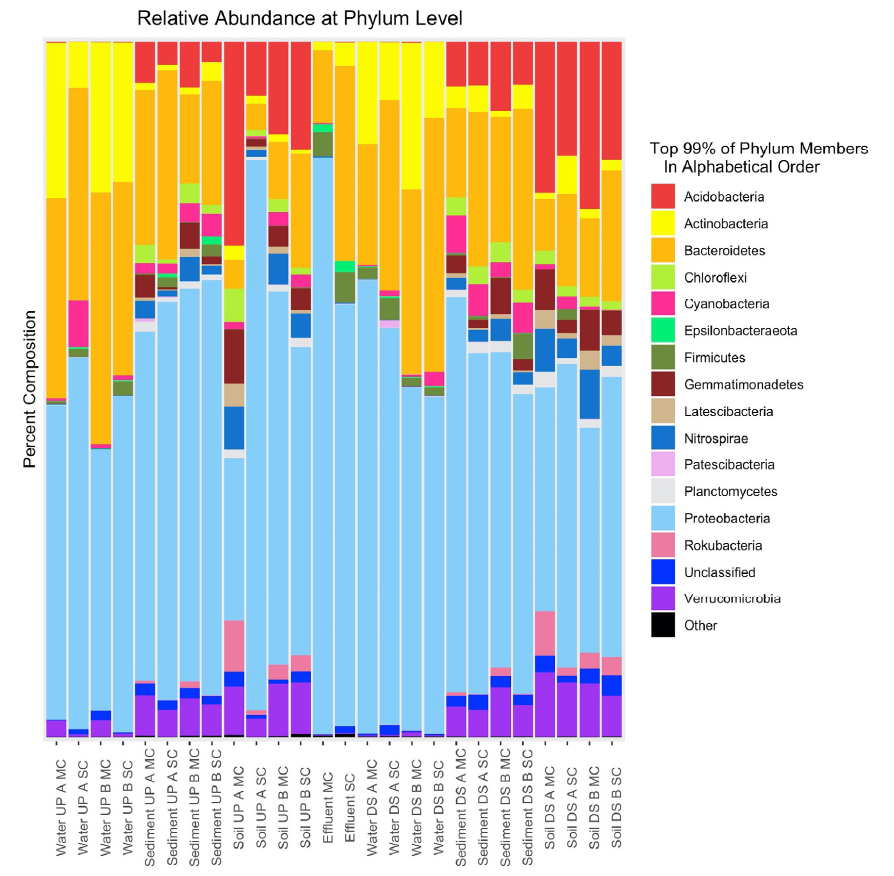
Figure 2. Relative abundance of the top 99% most abundant phyla in upstream and downstream water, sediment, and soils and water from wastewater treatment plant (WWTP) effluent, for both Mallard Creek and Little Sugar Creek. Sites are designated UP (upstream), DS (downstream), MC (Mallard Creek), SC (Little Sugar Creek). A and B refer to the 2 sample locations in each area.